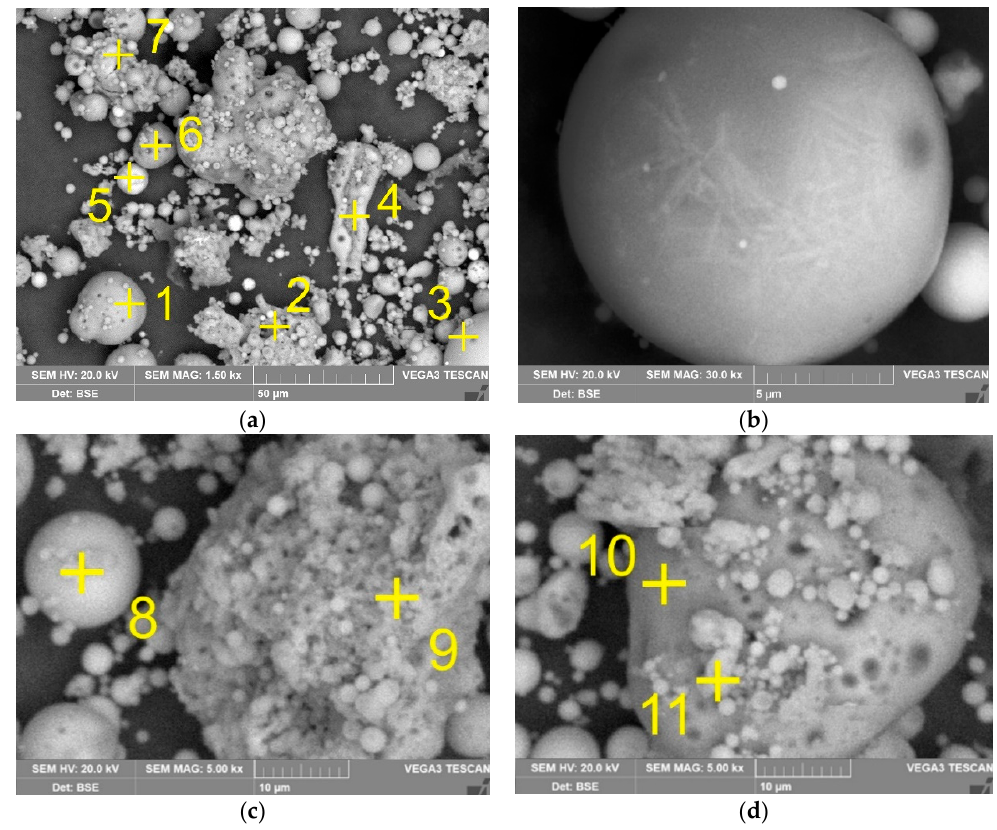
Figure 3. The SEM images of raw CFA at magnitude 1500 ( a ) mullite particles covered by amorphous aluminosilicate (A-S) at magnitude 30,000 ( b ) and at magnitude 5000 ( c , d ) (yellow cross indicates place of scanning electron microscopy with energy-dispersive X-ray spectroscopy (SEM-EDX) analysis; the elemental compositions are shown in Table 2).